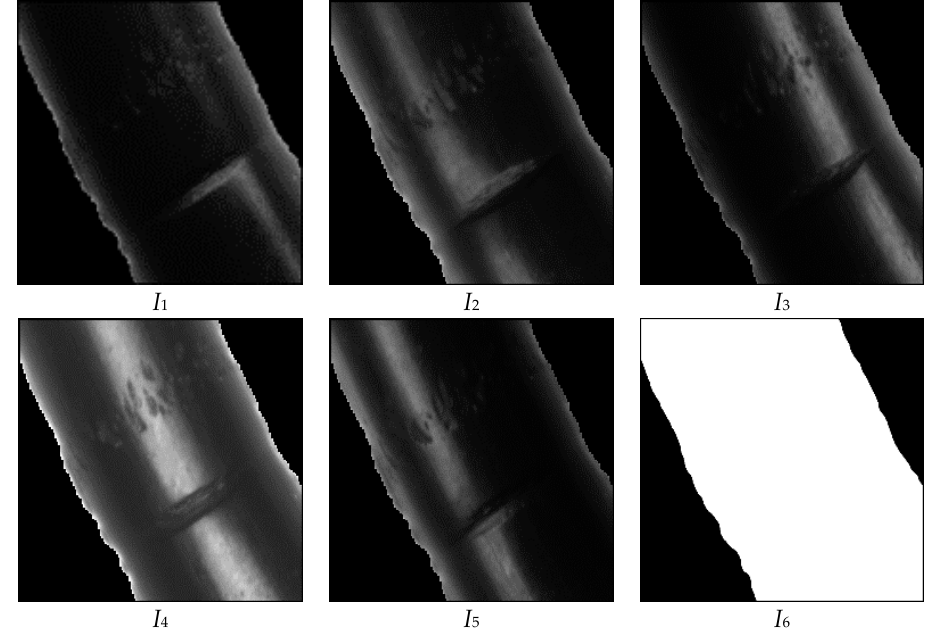
Figure 7. A set images I i ( i = 1,2,3,4,5,6) without background information.